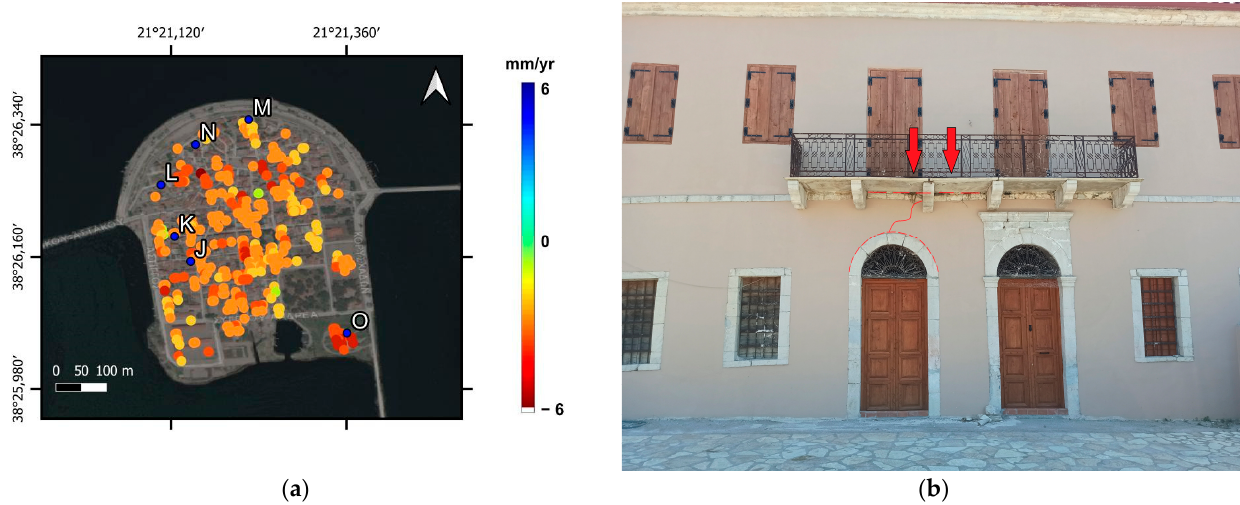
Figure 17. ( a ) Locations of buildings with recorded damages in Aitolikon. Vaso Katraki Museum’s location is represented as O ( b ) Building M—Balcony damage (South side of Aitolikon). Letters J, K, L, M, N, O indicate the location of the buildings where damages were recorded.